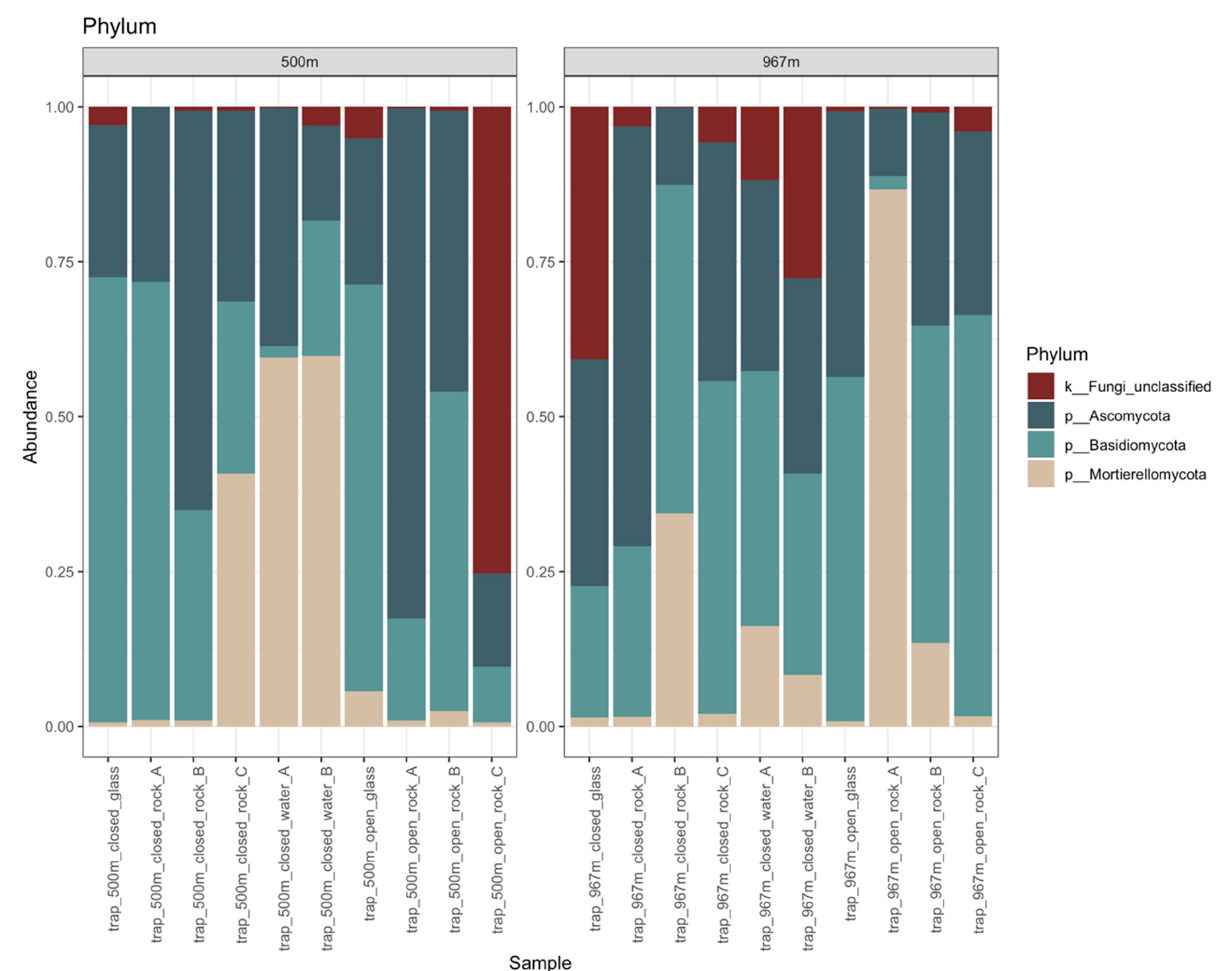
Figure 4. The relative abundance of fungal phyla detected at depths 500 and 967 m. In the legend on the right, k in front of the taxon name indicates identification to kingdom level, p indicates identification to phylum level.